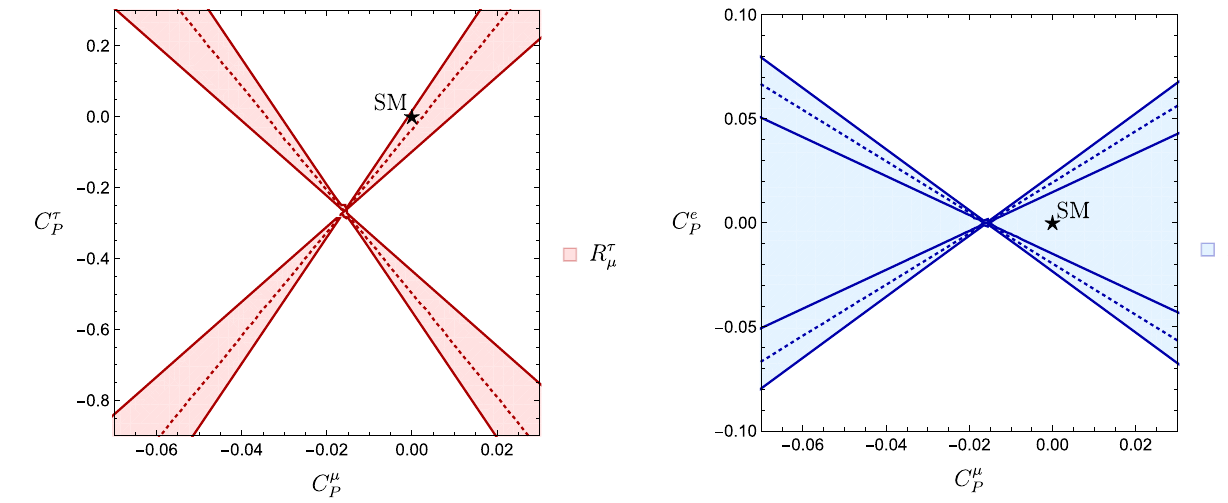
Fig. 2 Allowed regions in the C tonic ratio R e μ . The dotted line defines where the bound in Eq. (22) is saturated,withanerrorindicatedbythesolidlinesduetotheuncertainty of the measurement of B ( B − → μ − ¯ ν μ